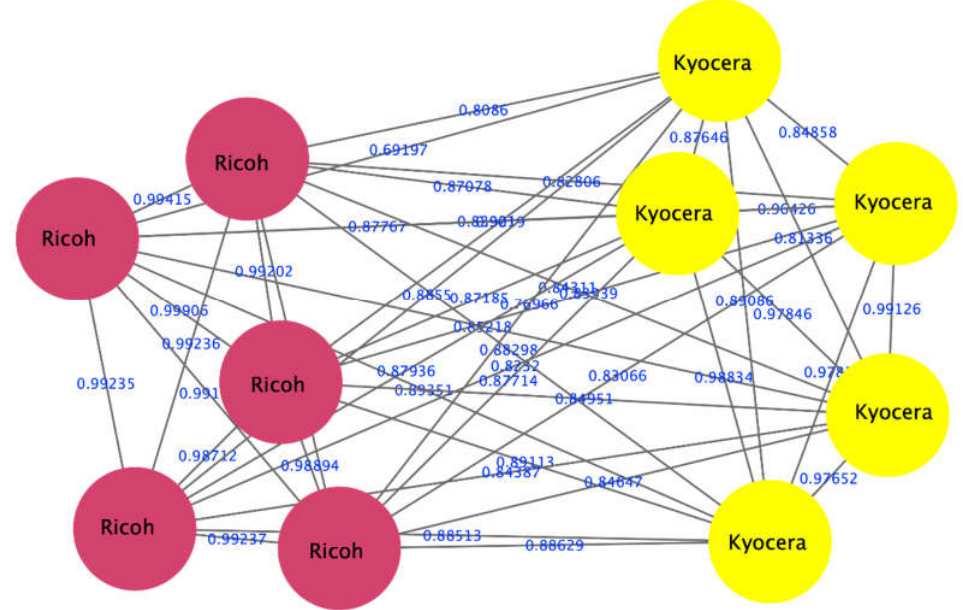
Figure 4. Visualizing a network consisting of two clusters, the first containing ink spectra of a Ricoh laser printer (red nodes). The second includes the ink spectra of a Kyocera laser printer (yellow nodes).